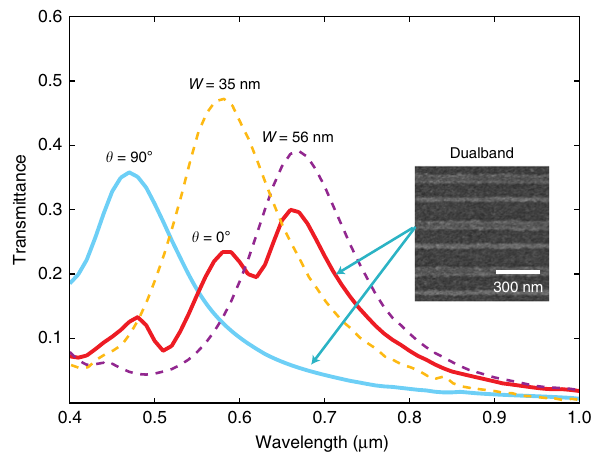
Fig. 3 Spectra transmission of dualband nanocavity. Experimentally obtained transmission spectra of dualband nanocavity with 60-nm-thick polymer spacer: the dualband metasurface consists of two different Ag gratings with 35 nm and 56 nm